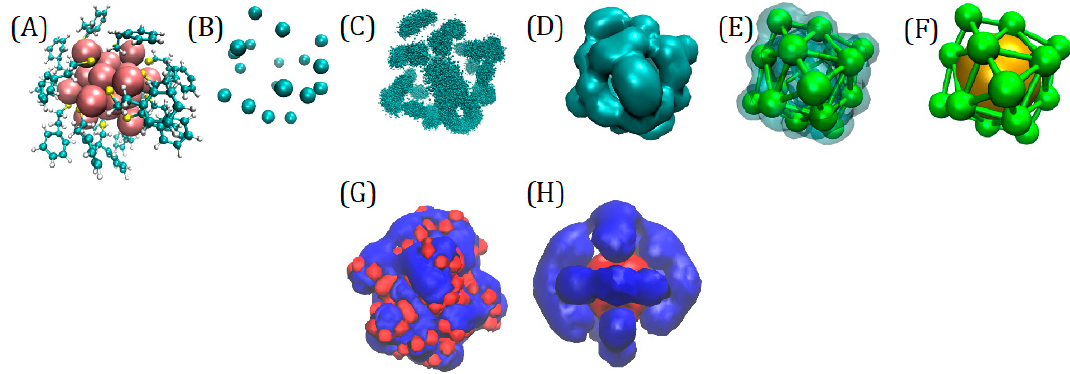
Figure 7. ( A ) Atomistic structure of the NP, ( B ) CG representation (only CS beads), ( C ) space clustering of the CS beads, ( D ) volume map based on CS positions, ( E ) CS location based on the volume map, ( F ) Complete CG model with AU. Representation of the electrostatic potentials around the NP: ( G ) atomistic model based on RESP (Restrained Electrostatic Potential) from GolP force field atom-based charges and ( H ) 19 beads CG model with charges obtained as sum of the constituent RESP atom charges (UHBD, University of Houston Brownian Dynamics, isosurfaces drawn at positive + 0.5 kcal / e (red) and negative − 0.5 kcal / e (blue)